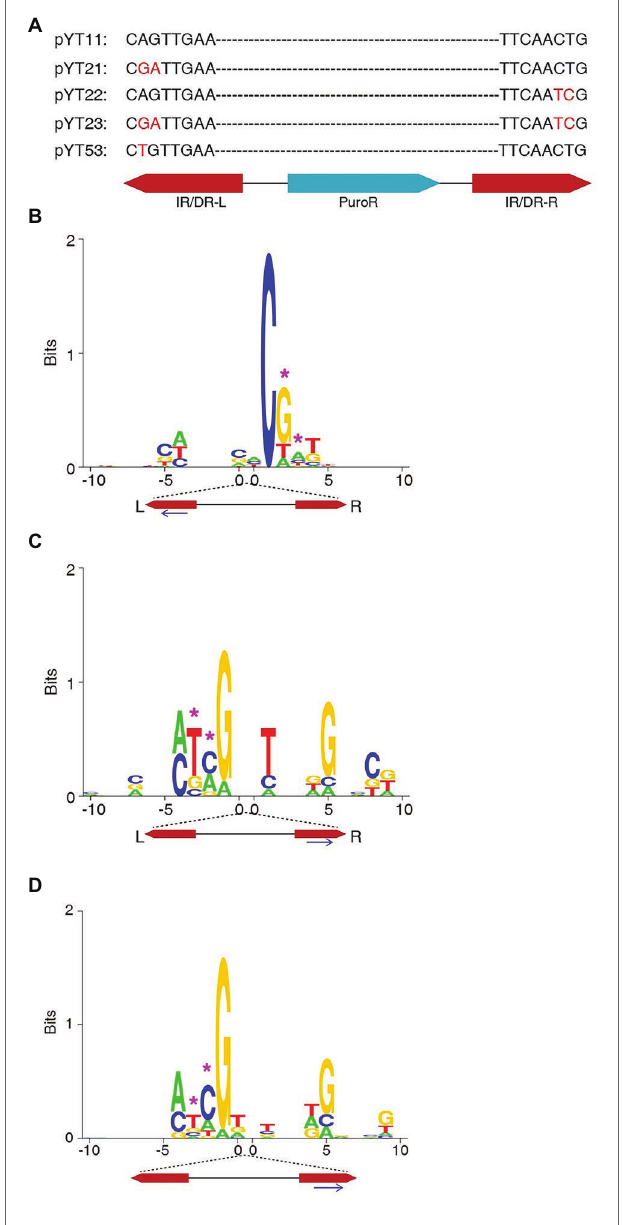
FIGURE 1 | The target site consensus sequences of the non-TA integrations of the transposons with mutated IR/DR ends. (A) The design of mutations at the IR/DR ends. (B) The consensus sequences of non-TA target sites of pYT23 sequence from the left end. (C) The consensus sequences of non-TA target sites of pYT23 sequenced from the right side. (D) The consensus sequences of non-TA target sites of pYT23. The sequences from both left and right were combined. The position corresponding to the mutations was labeled with pink